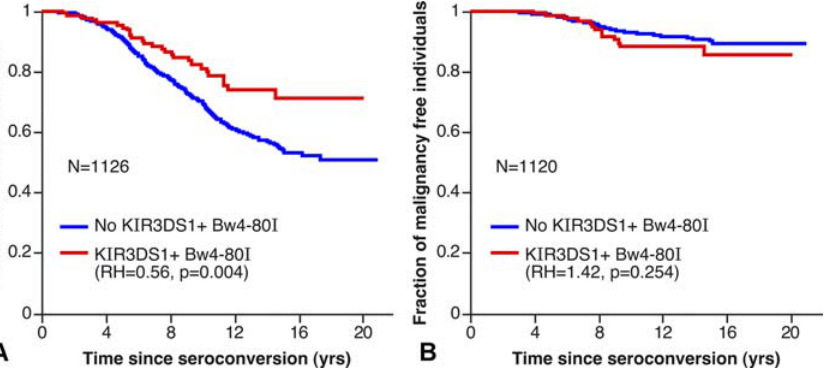
Figure 1. Effect of KIR3DS1/Bw4-80I on Progression to AIDS-Defining Illness Kaplan-Meier survival analyses illustrating the effect of KIR3DS1/Bw4-80I on progression to A) AIDS-defining opportunistic infections and B) AIDS- defining malignancies among seroconverters. Patients with KIR3DS1/Bw4-80I (red curve) were compared with patients missing this genotype (blue curve). RH and p -values from corresponding Cox models are given. DOI: 10.1371/journal.ppat.0020079.g001